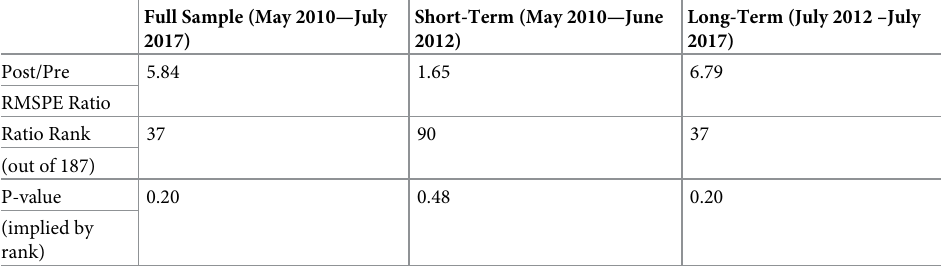
Table 3. BP post/pre RMSPE ratios and